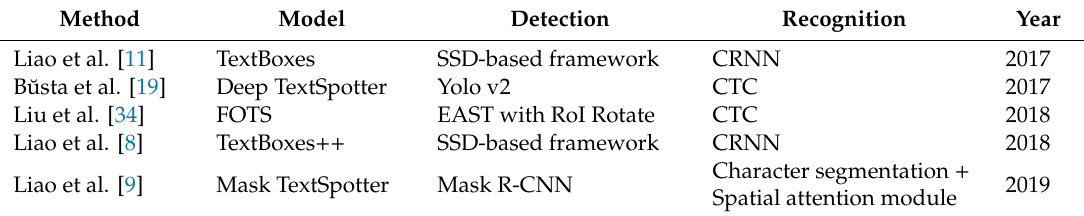
Table 1. Summary of recently proposed end-to-end scene text recognition